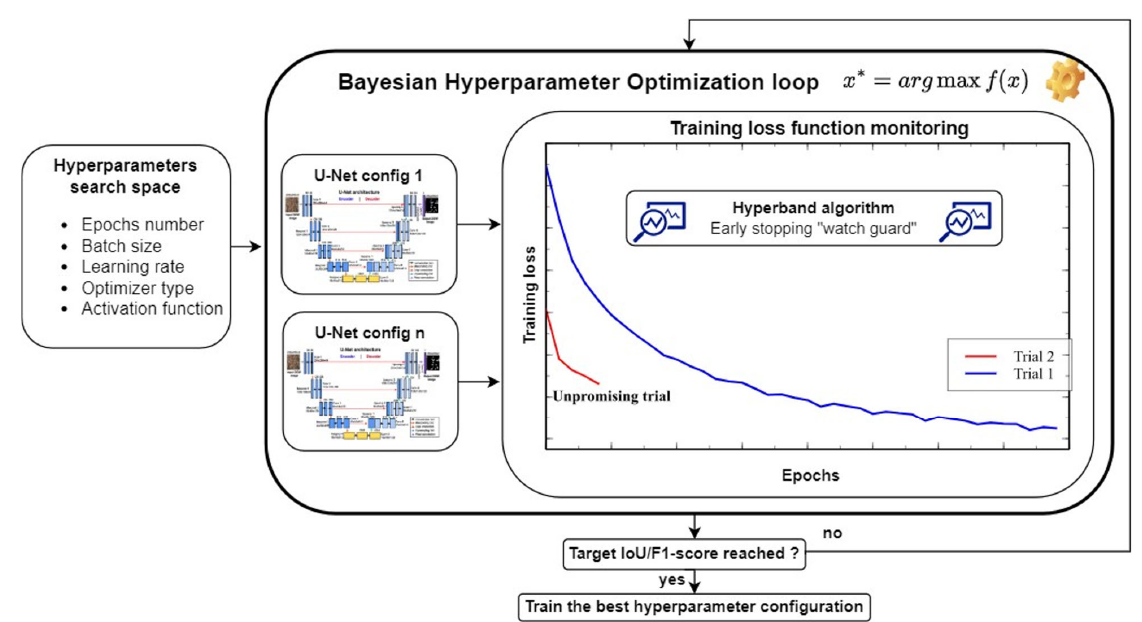
Figure 4. Bayesian hyperparameter optimization strategy.